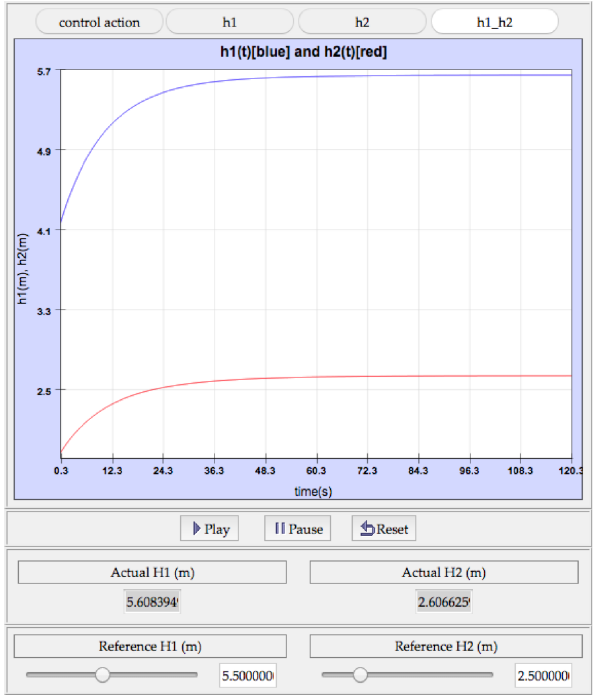
Figure 10. The evolution of the outputs considering the equations of the original (nonlinear) system.